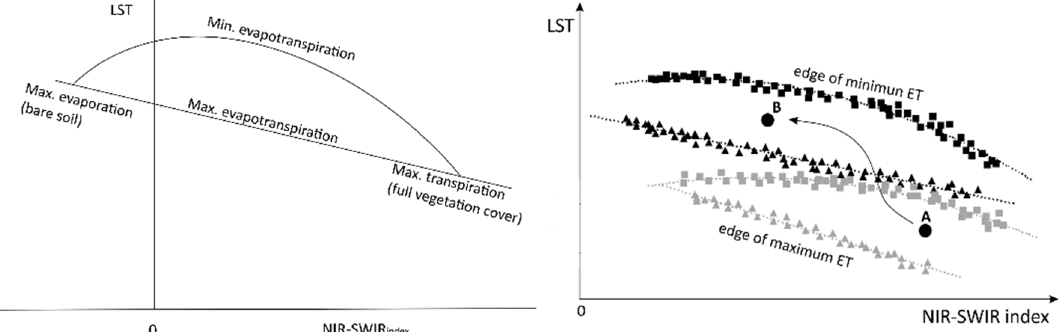
Figure 3. Left : general conceptual model of the NIR-SWIR/LST relationship (see NIR − SWIR index in Equation (3)). Right : Interpretation of remotely sensed LST/NIR-SWIR scatterplot using two examples of daily MODIS/Aqua data for the study area (EVI > 0.3). Triangles (rectangles) indicate edges of maximum (minimum) evapotranspiration (ET), and hence, water availability in the soil-plant system. The TIDI for a given pixel (e.g., A or B) is based on the distance to the edges. A path from A to B is suggested as a drying process for a given pixel. Grey: edges for a widespread wet condition, black: edges for a dry condition.